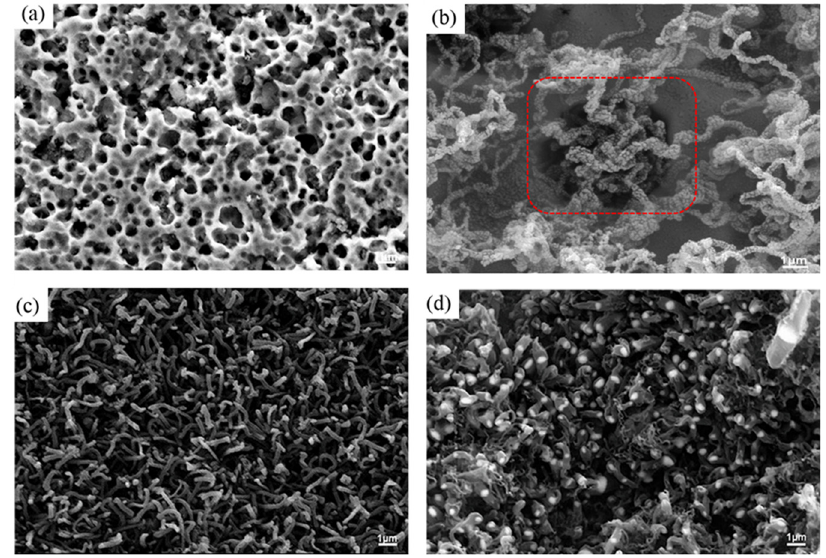
Figure 3: SEM spectra of metal substrate surface before and after the in situ growth of CNTs at di ff erent time. ( a ) Before CNTs growing; ( b ) growing for 10 s; ( c ) growing for 30 s; ( d ) growing for 60